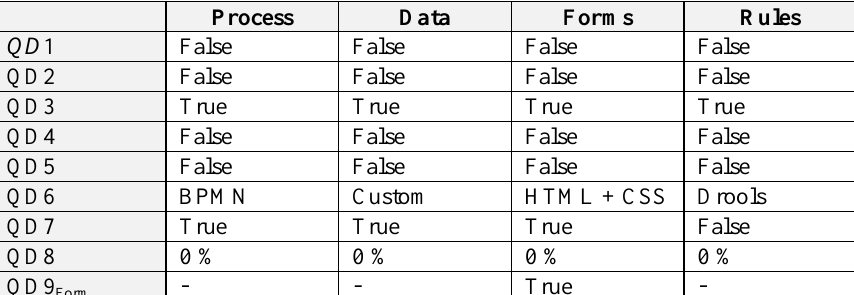
Table 6. Guiding questions and answers